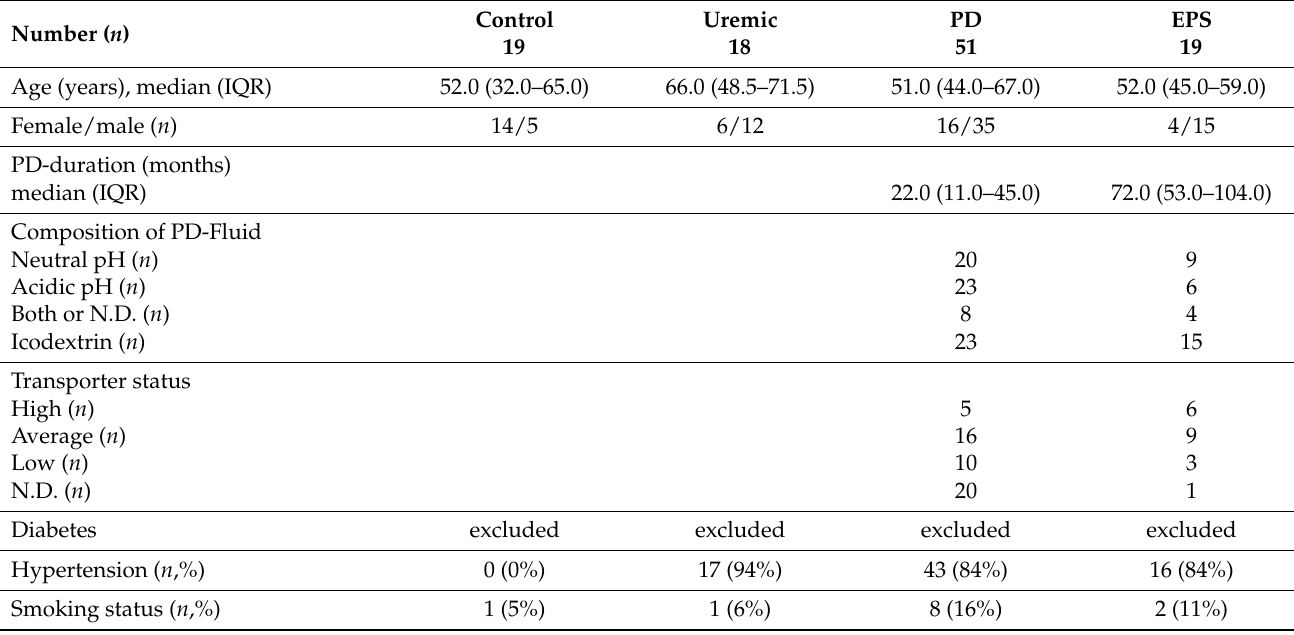
Table 1. Clinical data of study